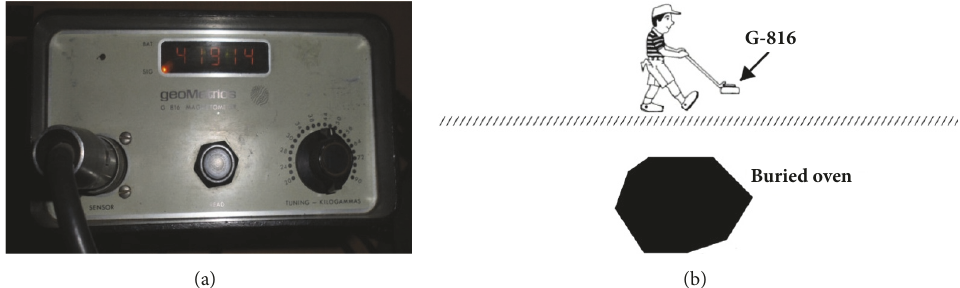
Figure 3: Materials and method used in the survey: (a) G-816 geometrics scalar magnetometer; (b) the magnetic